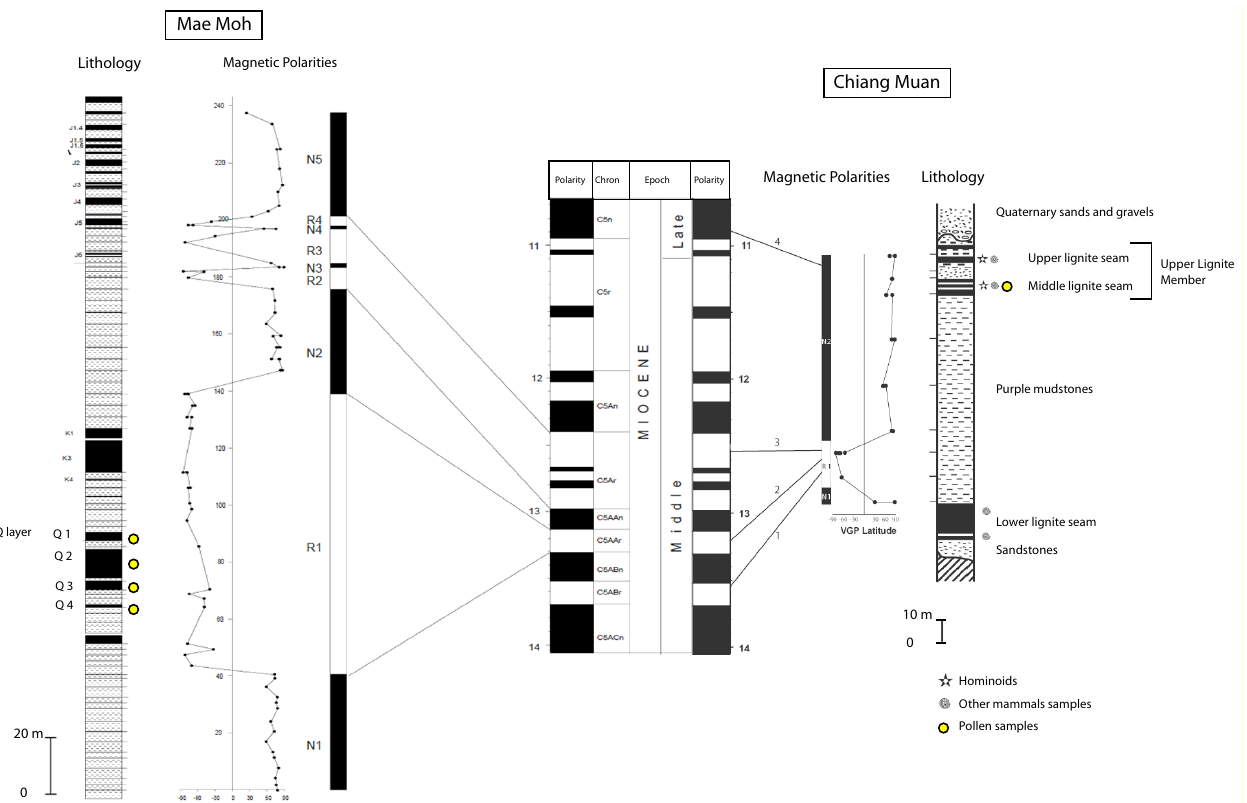
Fig. 2. Lithological information, magnetostratigraphy and stratigraphic control of Mae Moh and Chiang Muan pollen samples (after Bennami et al., 2002,